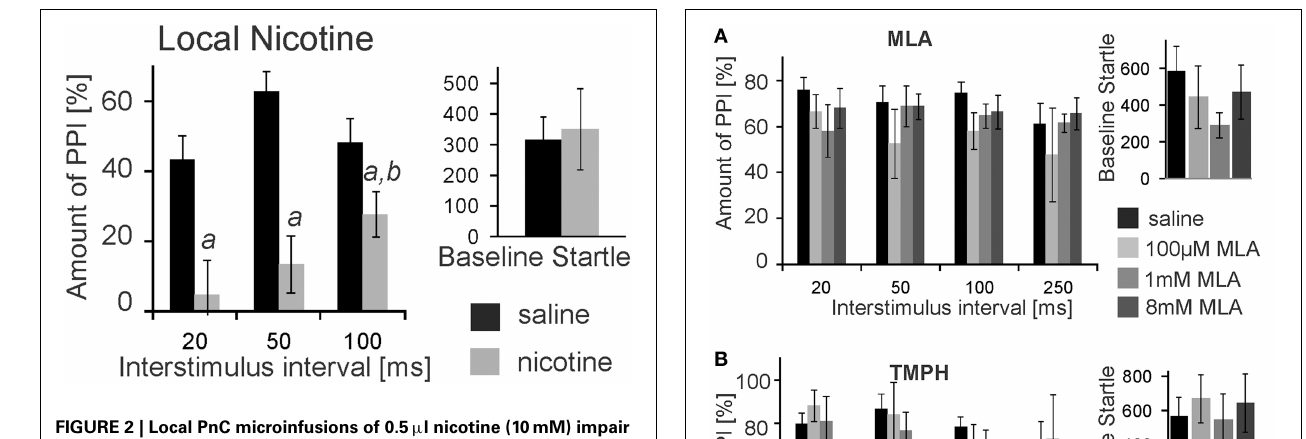
FIGURE 2 | Local PnC microinfusions of 0.5 μ l nicotine (10mM) impair PPI. Rats were bilaterally injected with 10mM nicotine (in 0.5 μ l saline) or vehicle through chronically implanted cannulae targeting the PnC. They were immediately tested for startle and PPI using a 75 db white noise prepulse. The amount of PPI was significantly decreased in rats injected with nicotine when compared to rats injected with saline (labeled by “ a ”). The decrease was significantly stronger at 20ms interstimulus intervals compared with 100ms intervals (labeled by “ b ”). Baseline startle amplitudes did not significantly differ between groups ( n = 9 rats).